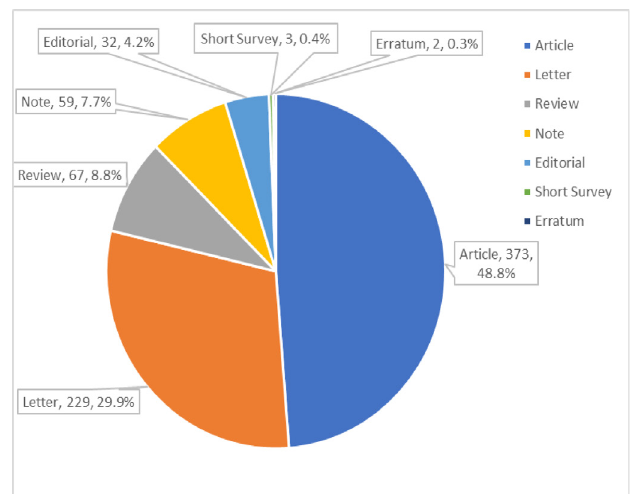
Figure 1. Coronavirus disease 2019 (COVID-19) publication types, publication numbers, and proportions of all COVID-19 publications in emergency medicine journals in 2020.